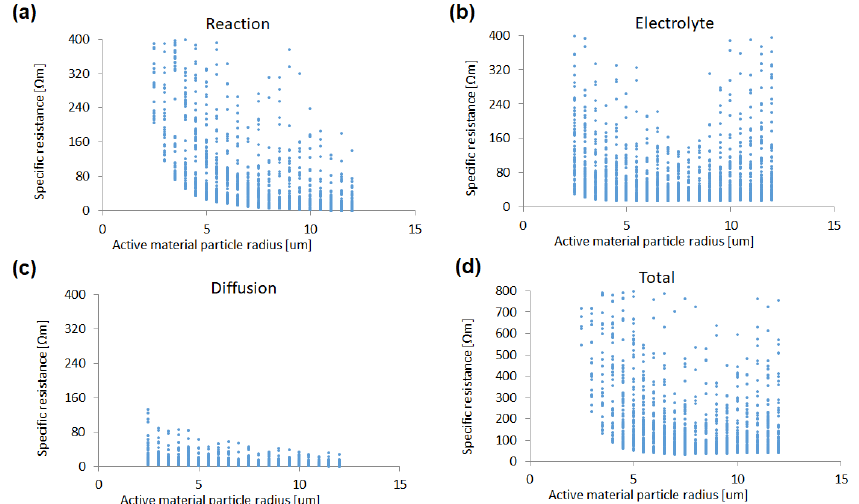
simulation results.